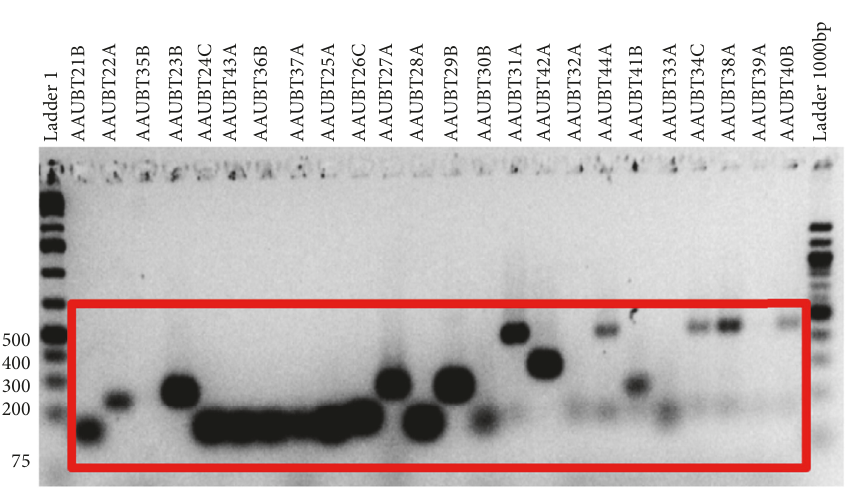
Figure 1: PCR amplification of yeast ITS DNA bands amplified by ITS1 and ITS2 yeast.